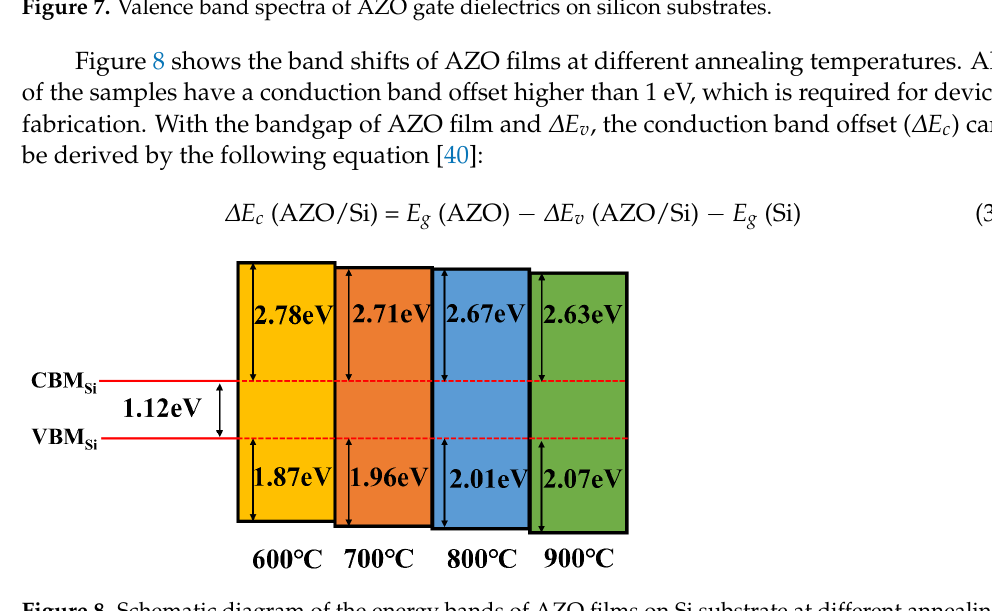
Figure 7. Valence band spectra of AZO gate dielectrics on silicon substrates.